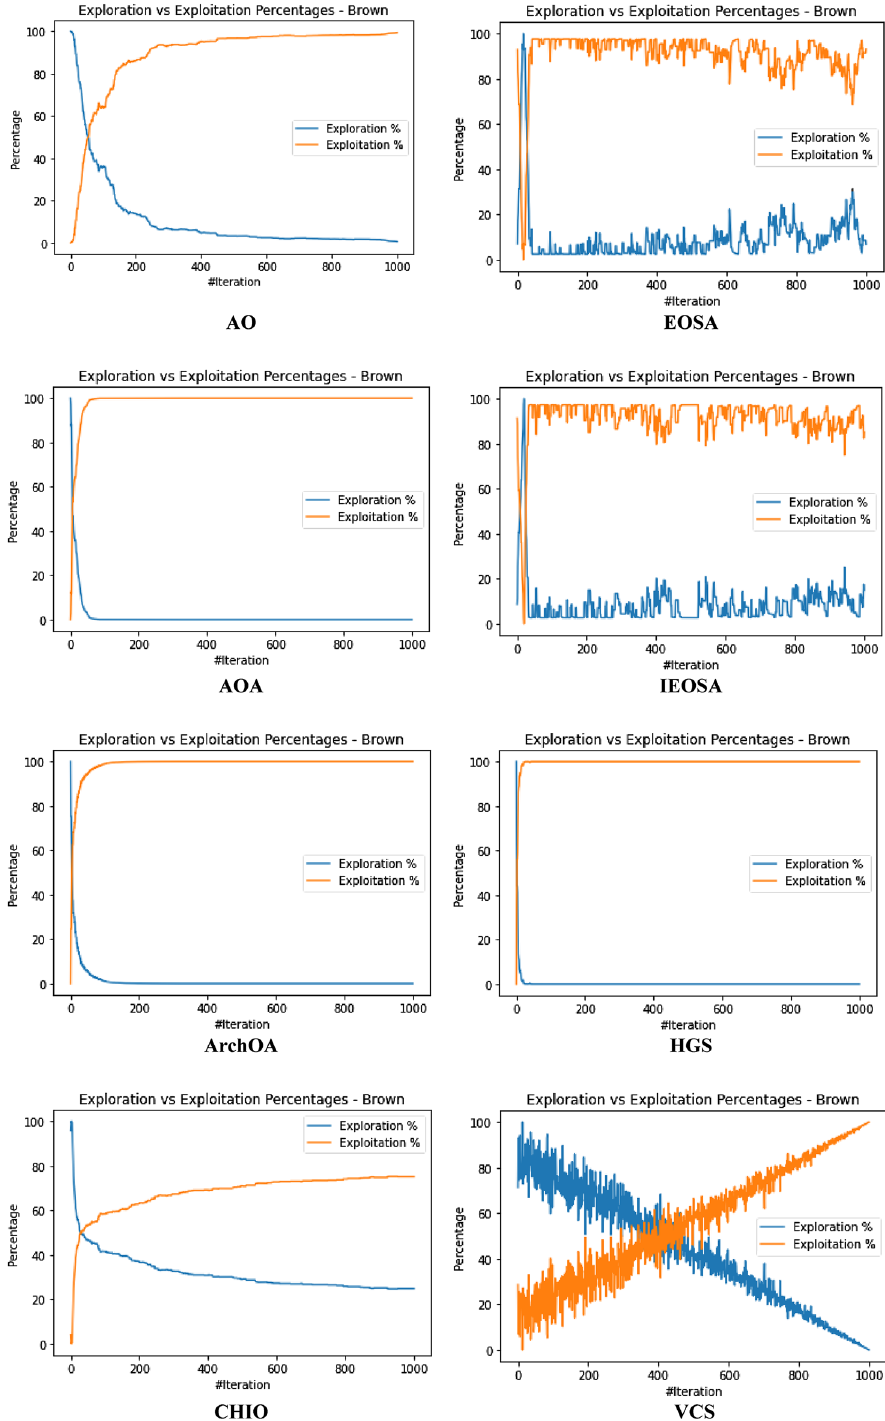
Figure 6. Illustration of the exploration and exploitation of Brown (F2) function for IEOSA as compared to AO, EOSA, AOA, IEOSA, ArchOA, HGS, CHIO, VCS, GA, and